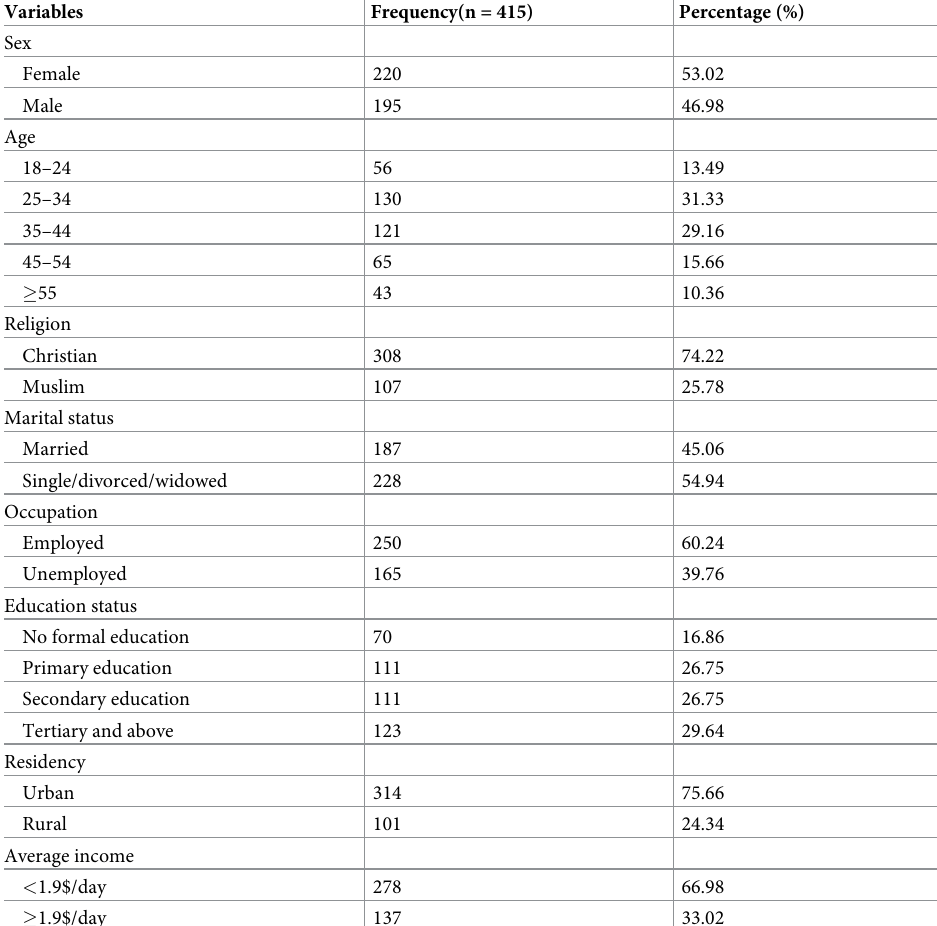
Table 1. Socio-economic and demographic characteristics of study